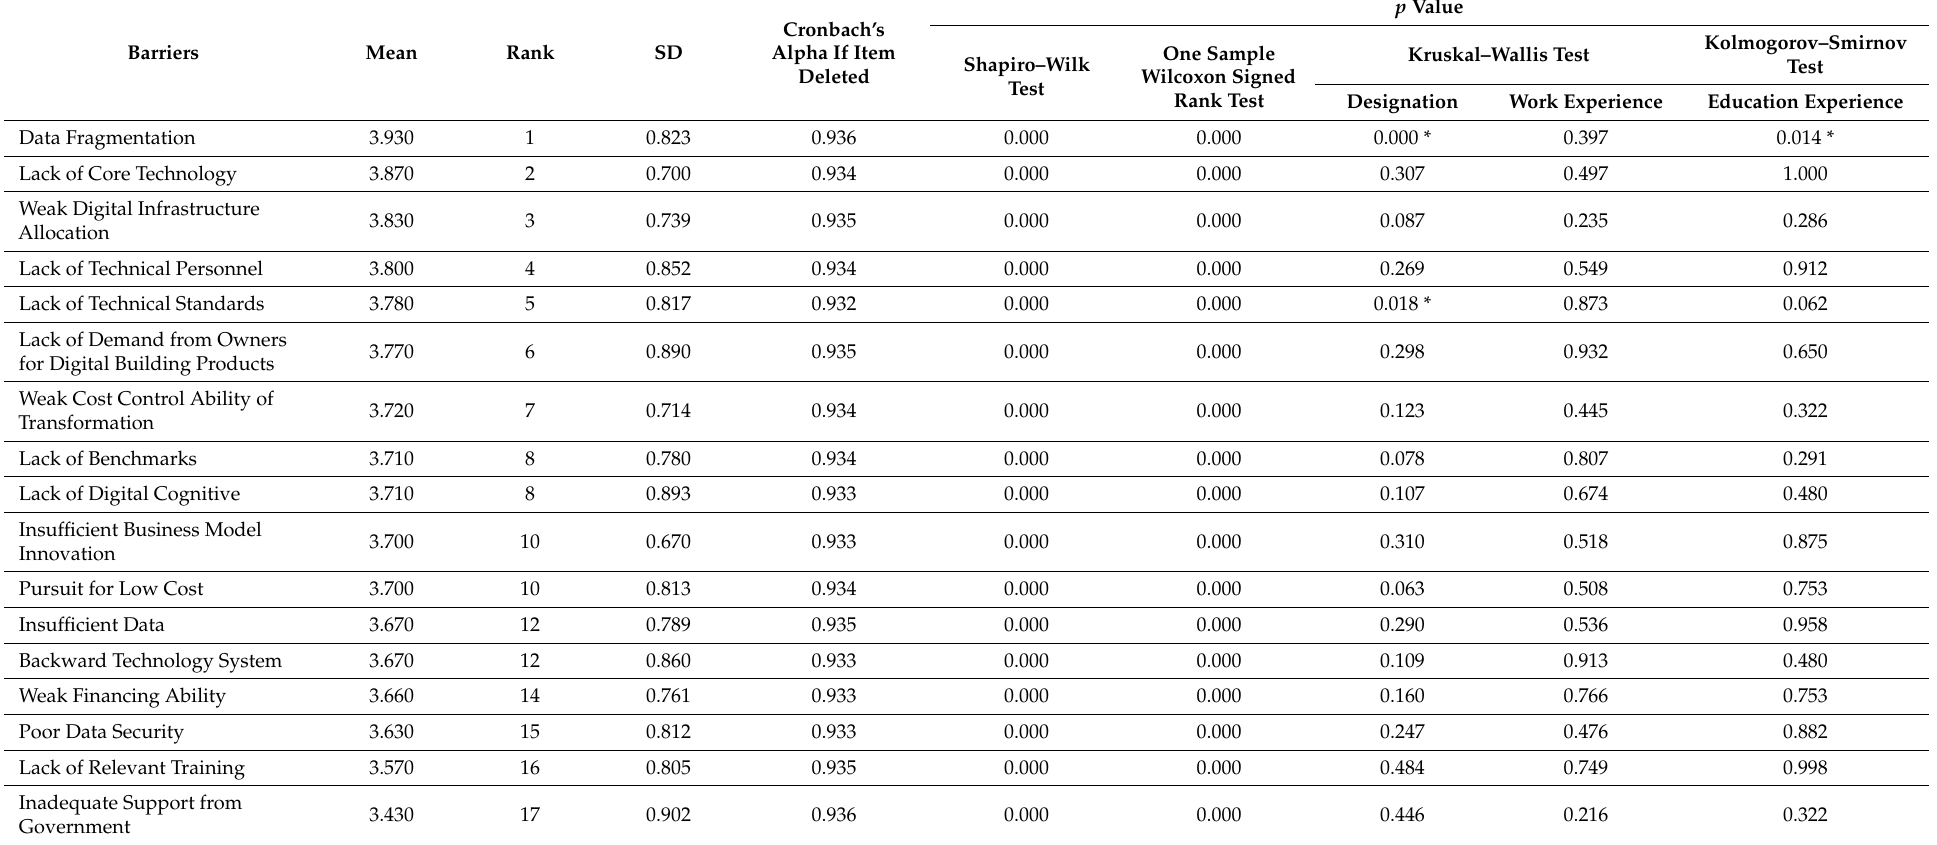
Table 6. Data analysis